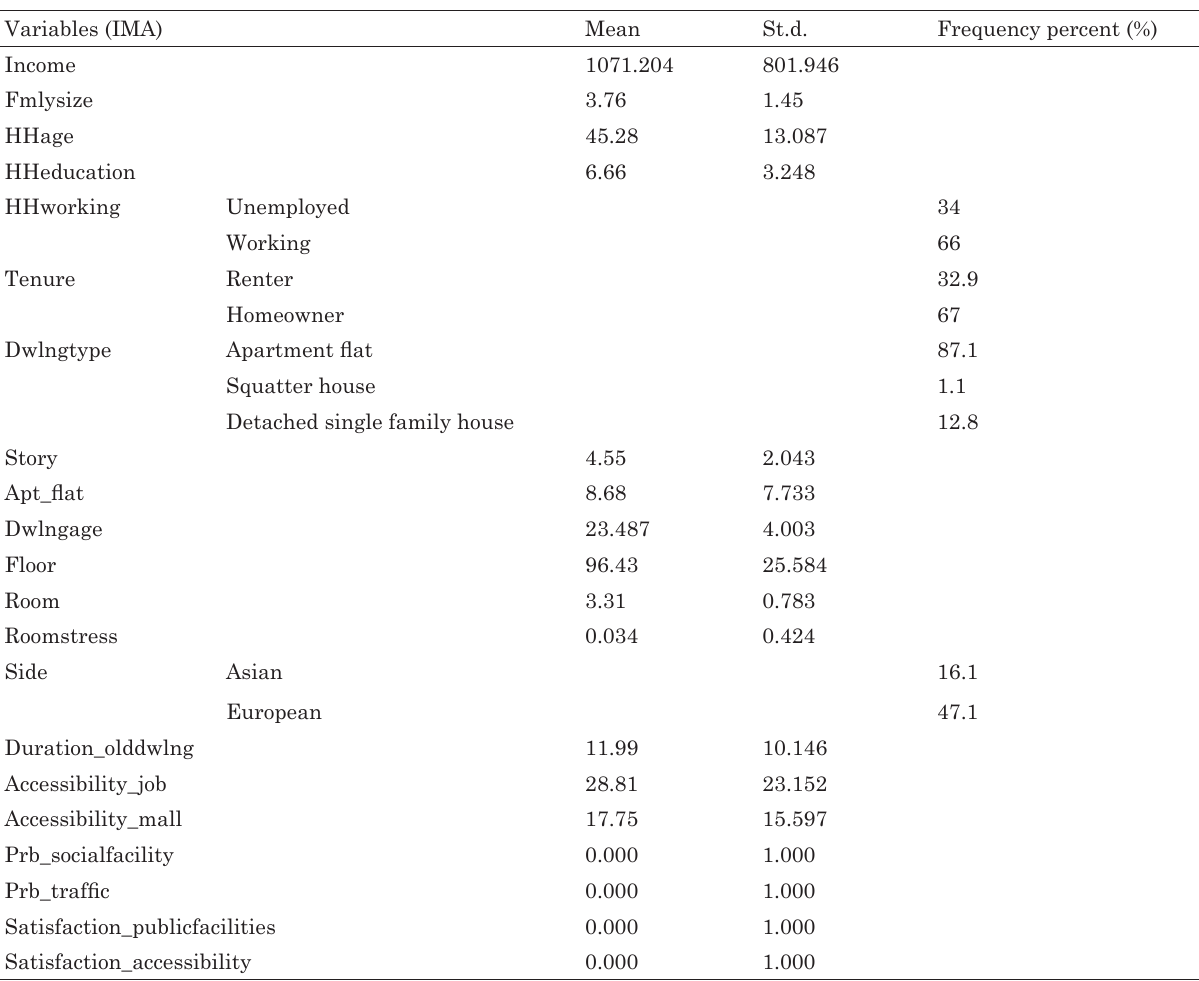
Table 2. The descriptive statistics